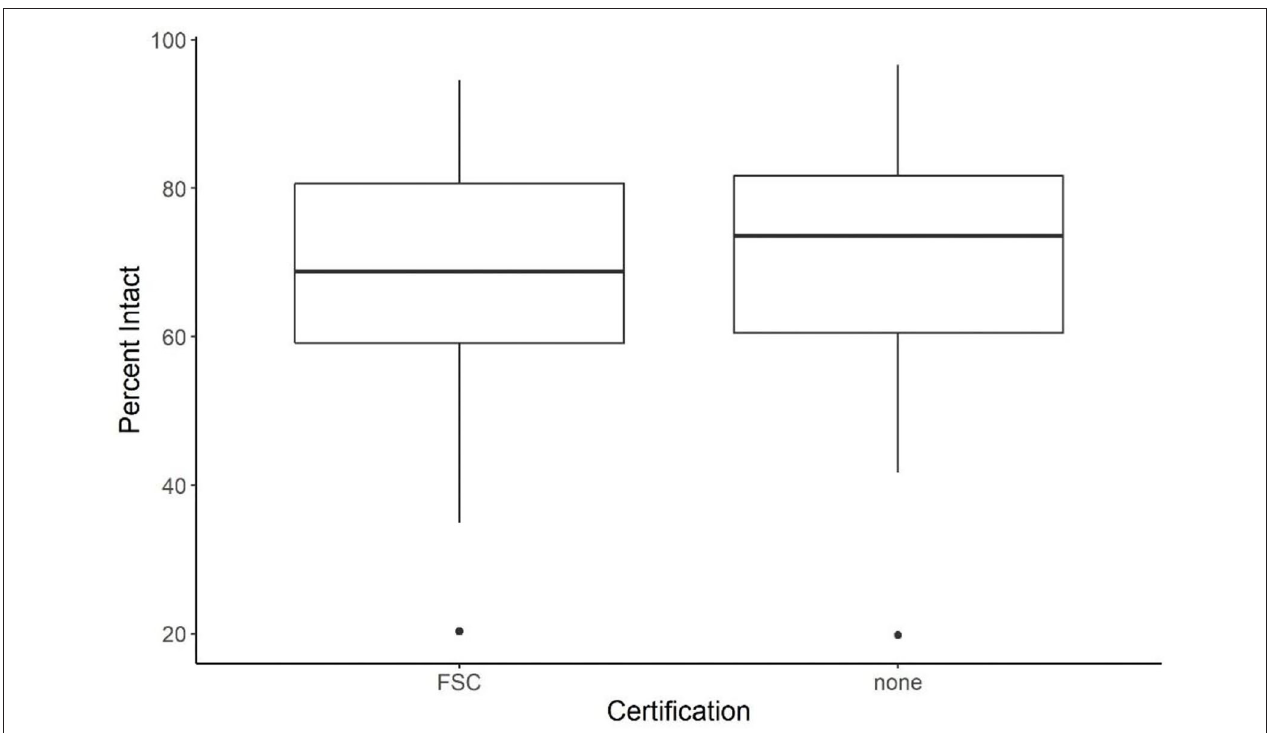
FIGURE 4 | A naïve comparison of the proportions of intact forest in Forest Stewardship Council (FSC; N = 12) and non-certified forest management enterprises ( N = 36). Box plot hinges correspond to first and third quartiles, and whiskers extend to highest and lowest values.